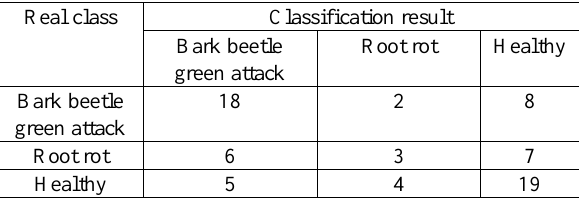
Table 2. Confusion matrix for the tree health classification using model based on hyperspectral data from 17